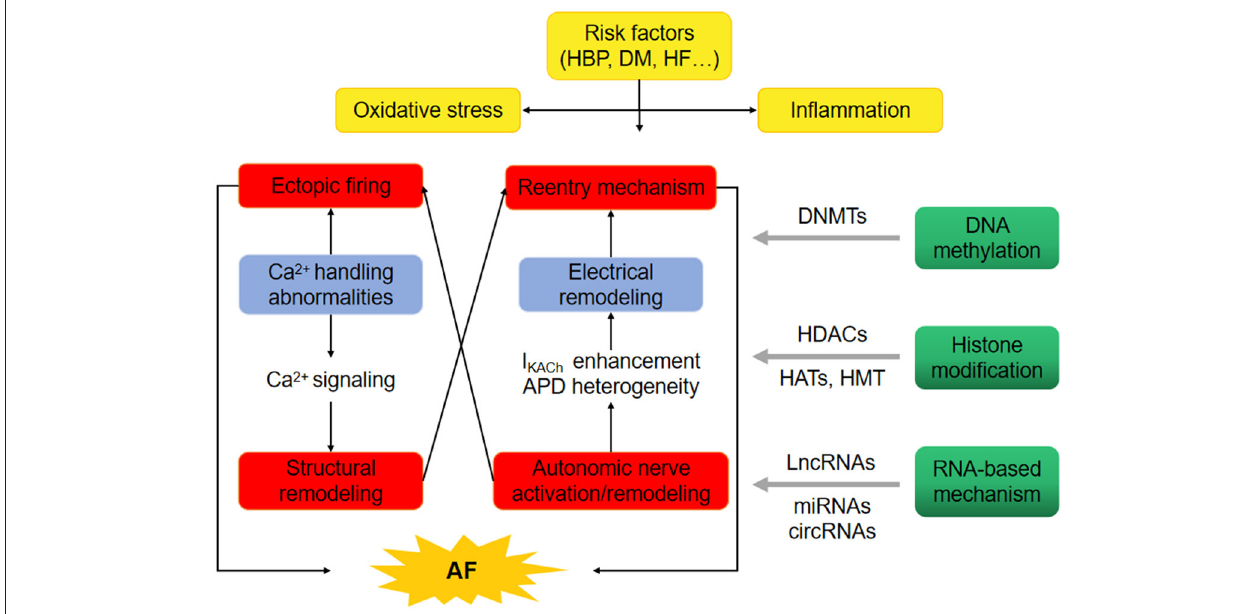
FIGURE 1 | Epigenetics provide the basis for uncovering the pathophysiology of atrial fibrillation (AF). The oxidative stress and inflammation in high blood pressure (HBP), diabetes mellitus (DM) and heart failure (HF) probably promote the occurrence of AF through ectopic firing and reentry mechanism. Epigenetic regulatory mechanisms, involving DNA methylation through DNA methyltransferases (DNMTs), histone modification through histone acetyltransferases (HATs), histone methyltransferases (HMT) and/or histone deacetylases (HDACs), non-coding RNAs such as long-ncRNA (LncRNAs), microRNAs (miRNAs) and circular RNAs (circRNAs) may comtribute to the initiation of